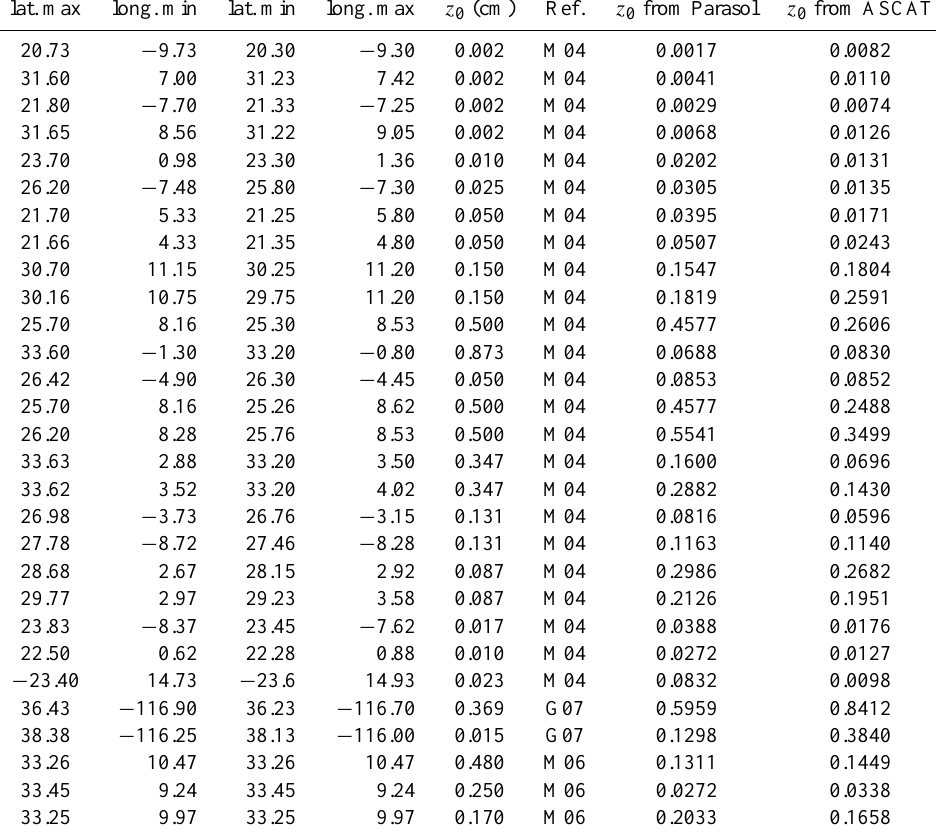
Table 1. Aeolian aerodynamic roughness length in situ estimates from pedological observations (Marticorena et al., 2004, M04 in the table), and from wind profile estimates (Greeley et al., 1997, G07; and Marticorena et al., 2006, M06). lat. max long.